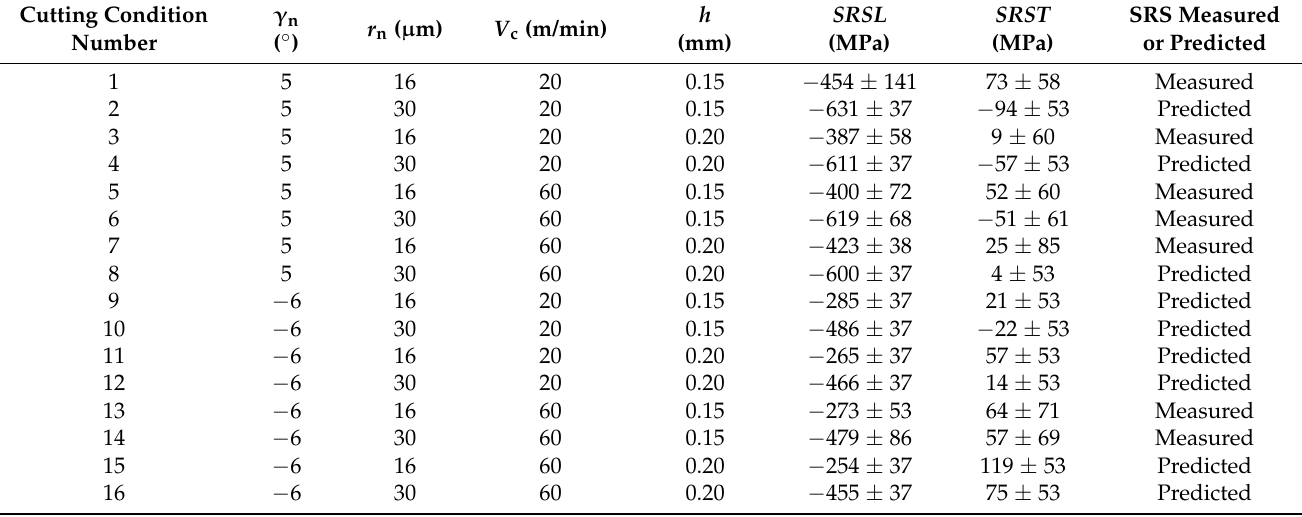
Table 9. Experimental and predicted/estimated residual stress results at the machined surface.